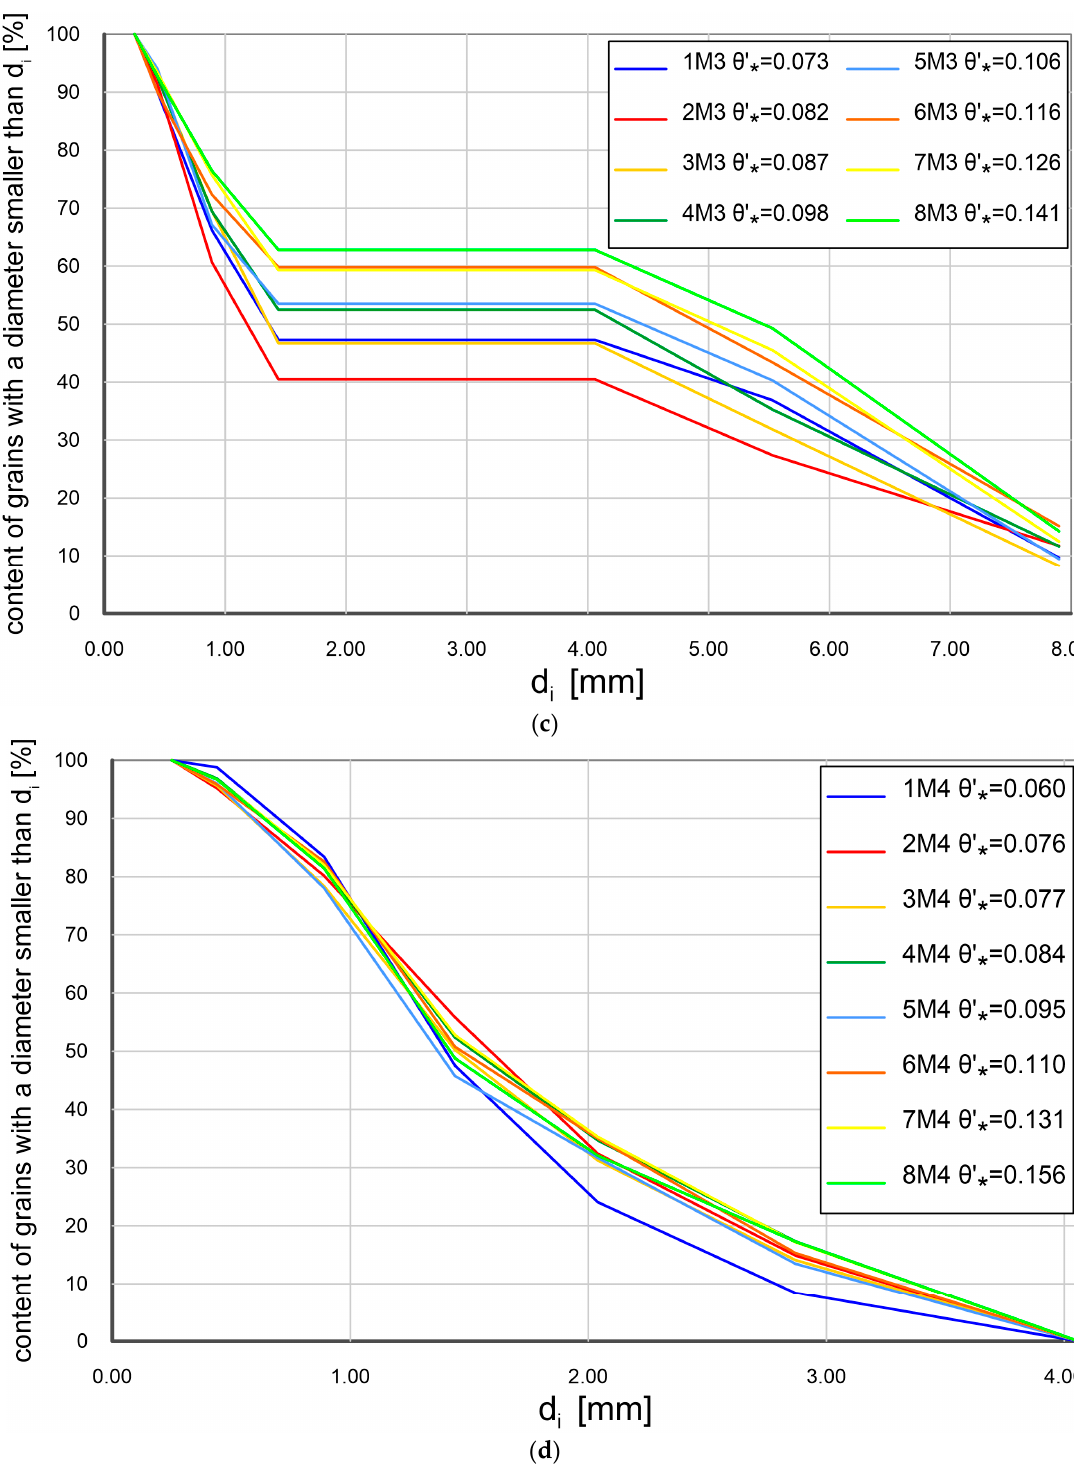
Figure 7. Particle size distribution determined for various mixtures caught in a trap in the experiments by [54], tests 1–8 for the initial particle size distribution ( a ) M1, ( b ) M2, ( c ) M3, ( d ) M4. Table 2. Main parameters and transport results by Elhakeem and Imran (2012) [54].